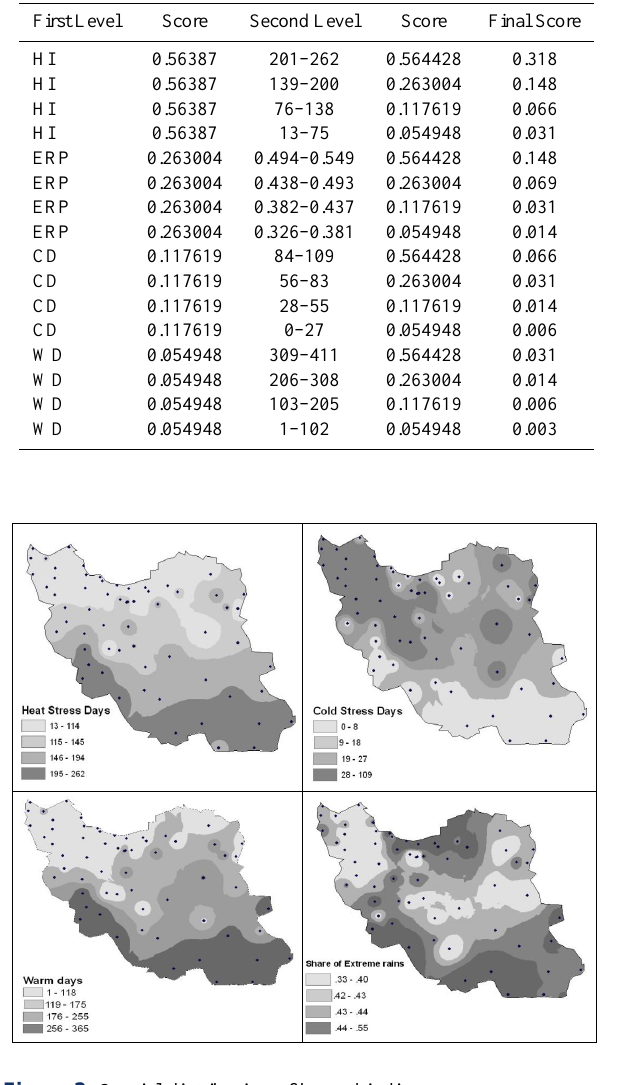
Figure 2. Spatial distribution of hazard